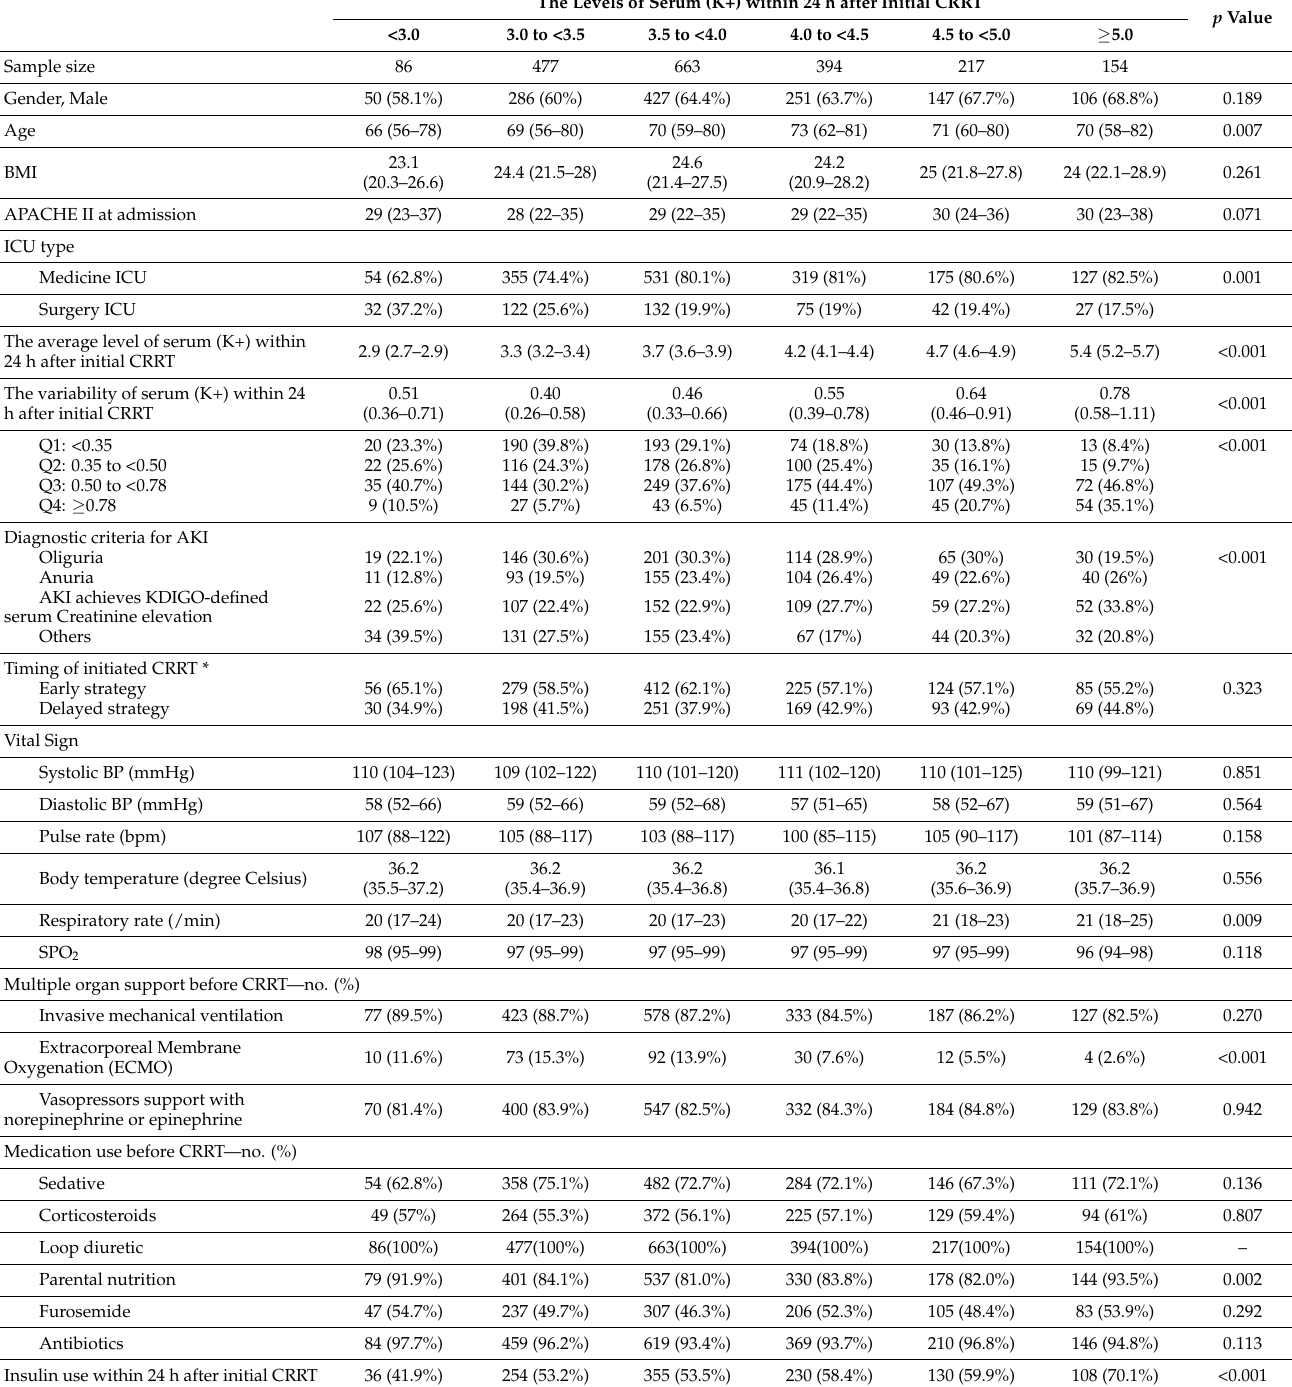
The Levels of Serum (K+) within 24 h after Initial CRRT